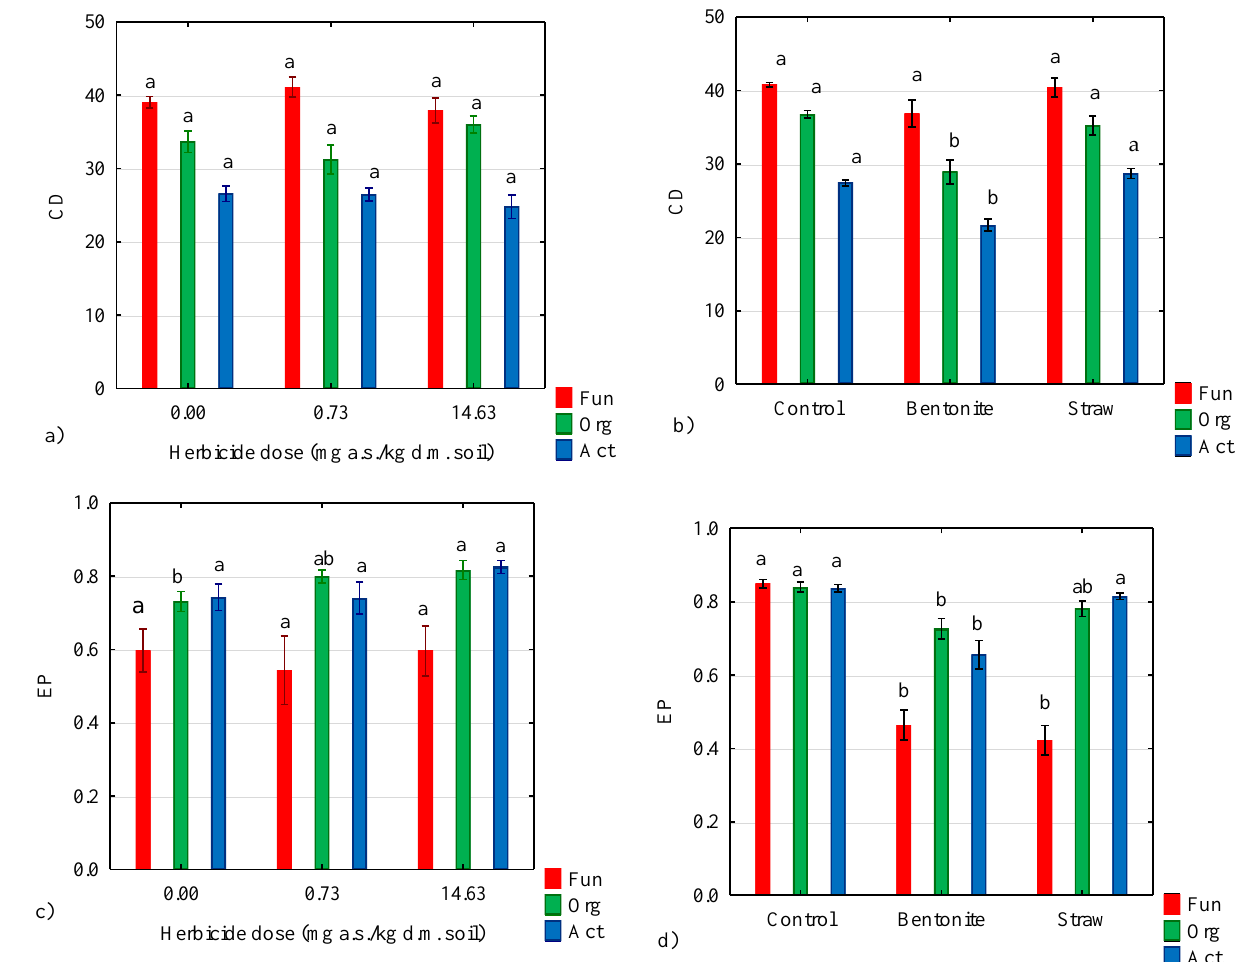
Figure 3. Ecophysiological biodiversity index (EP) and colony development index (CD) in soil contaminated with Successor T 550 SE. ( a ) CD in relation to a herbicide dose; ( b ) CD in relation to bentonite and straw; ( c ) EP in relation to a herbicide dose; ( d ) EP in relation to bentonite and straw. Fun—fungi; Org—organotrophic bacteria; Act—actinobacteria; herbicide dose: 0; 0.73; 14.63 mg a.s./kg soil; a.s.—active substance. The same letters denote homogeneous groups within a given microorganisms group.